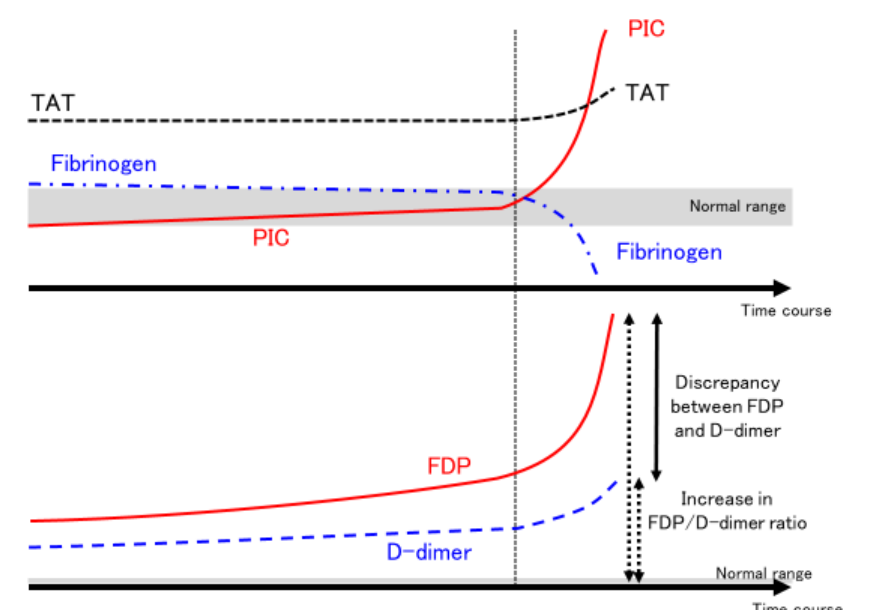
Figure 2. Dynamic changes in fibrinolytic pathophysiology in some severe COVID-19 cases. The time course of coagulation markers in COVID-19 patients with sudden enhancement of fibrinolytic activation and severe bleeding are shown. In some severe COVID-19 patients, PIC suddenly increases (PIC surge) at a certain point (around 7–10 days after admission to the ICU, as indicated by the vertical dotted line). At the same time, fibrinogen decreases significantly, but the degree of increase in TAT does not change significantly (upper panel). Meanwhile, FDP increases significantly, while D-dimer increases only mildly. Both solid and dotted arrows indicate the FDP/D-dimer ratio (lower panel). As PIC increases and fibrinogen decreases, discrepancy between FDP and D-dimer or the FDP/D-dimer ratio increases. These changes in coagulation markers are suggestive of en-